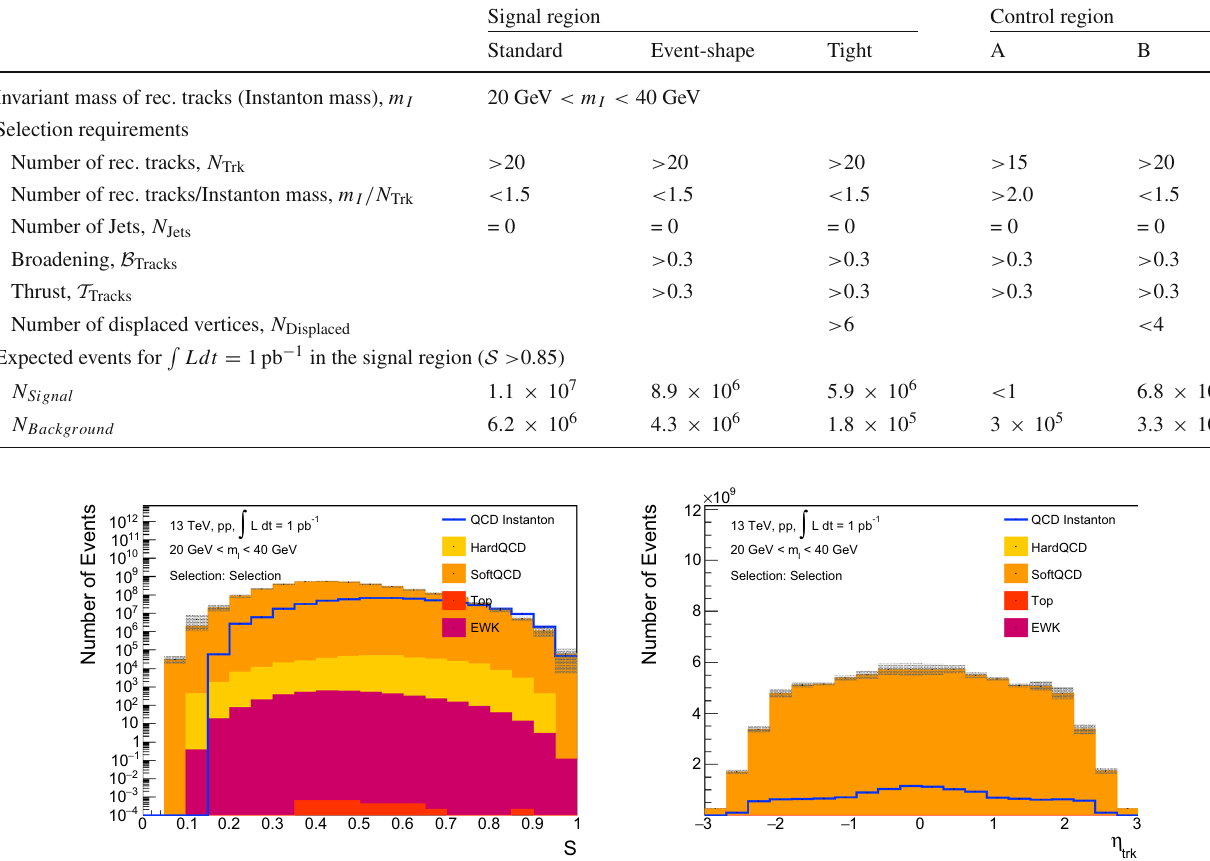
Table 3 Overview of the standard and tight signal selection as well as the definition of two control regions aiming at very low Instanton masses (20 GeV < m